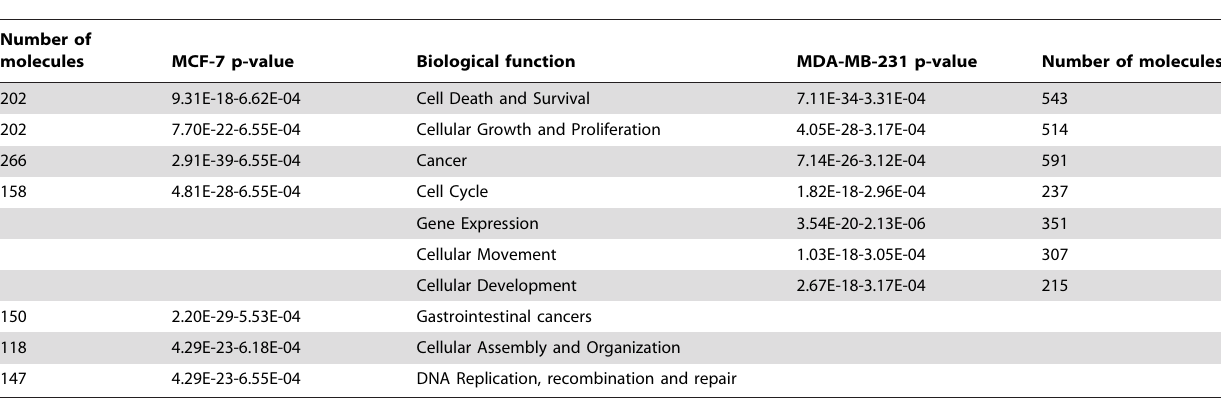
Table 1. The top biological processes affected by WA in MCF-7 and MDA-MB-231 cells after 72-hour exposure to 700 nM WA.